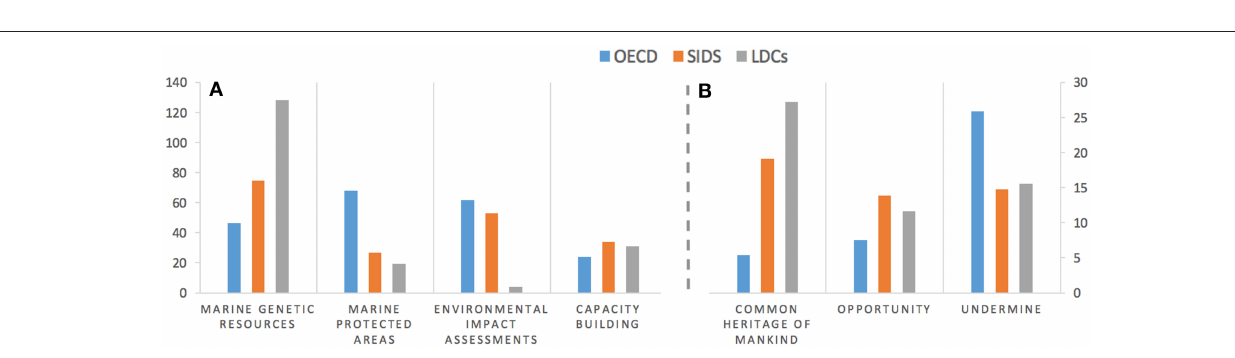
FIGURE 4 | Weighted frequency with which states and groups made reference to (A) the four elements of the package; (B) other indicative